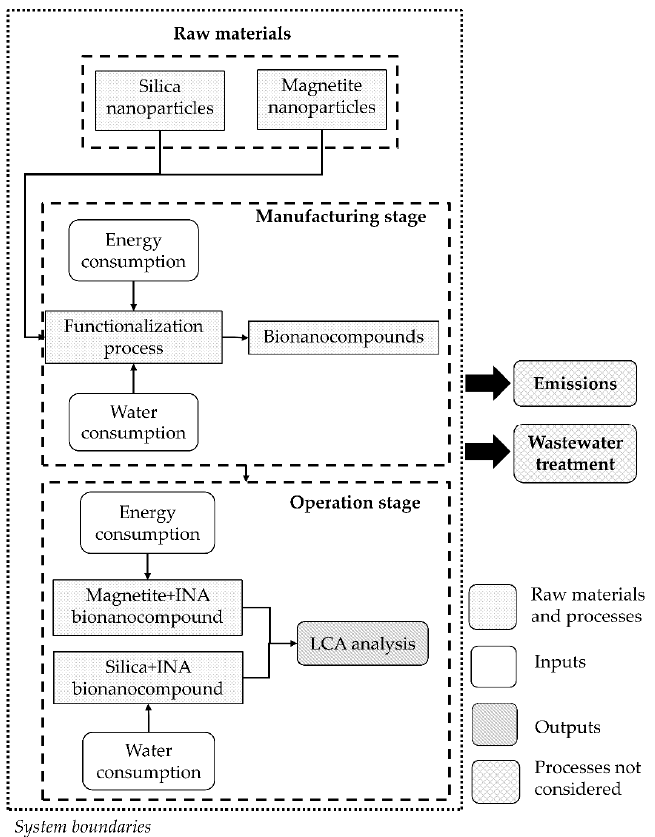
Figure 1. Flow diagram of the manufacturing and operation stages for usage of the bionanocom- pounds.